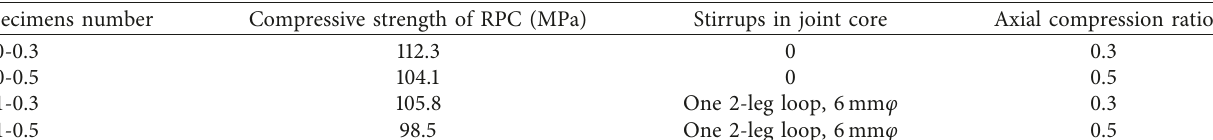
Table 1: Specimen parameters.